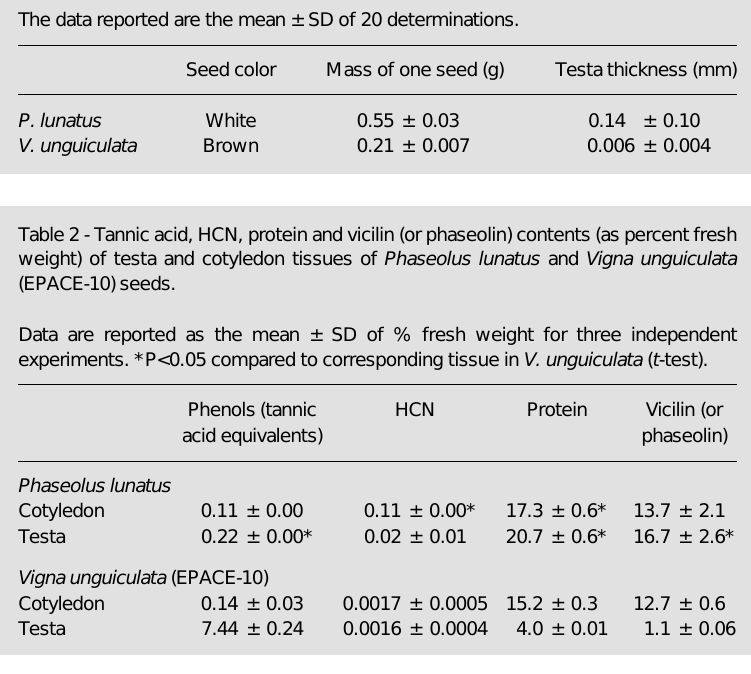
Table 1 - Characteristics of Phaseolus lunatus (“Ceará” landrace) and Vigna unguiculata (EPACE-10) seeds. The data reported are the mean ± SD of 20 determinations.